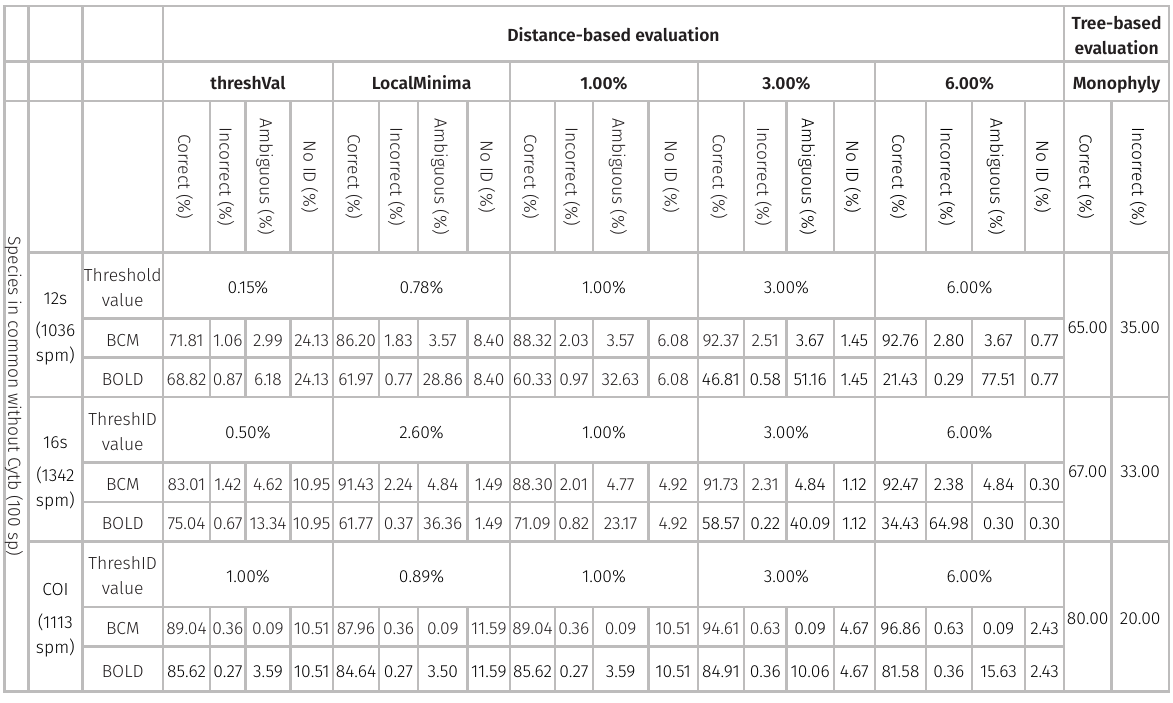
Table IV. Results of the identification simulations from “Species in common without Cytb” datasets using Best Close Match (BCM) and BOLD ID criteria based on SPIDER and tree-based comparison of efficiency among the studied barcoding markers using the percentage of monophyletic groups recovered from the neighbor-joining phylogenetic